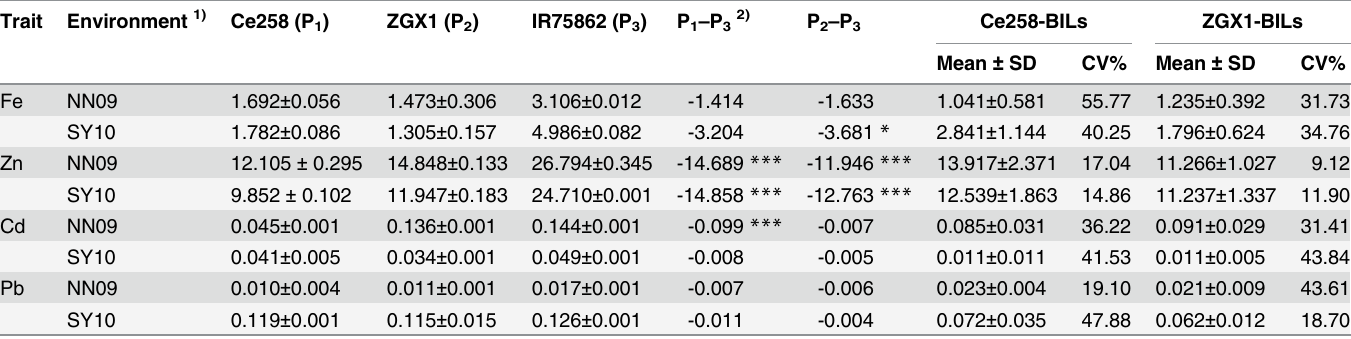
Table 2. Phenotypic values of grain mineral concentrations detected in three parents and two sets of BILs in two environments (mg kg -1 ). Trait Environment 1) Ce258 (P 1 )